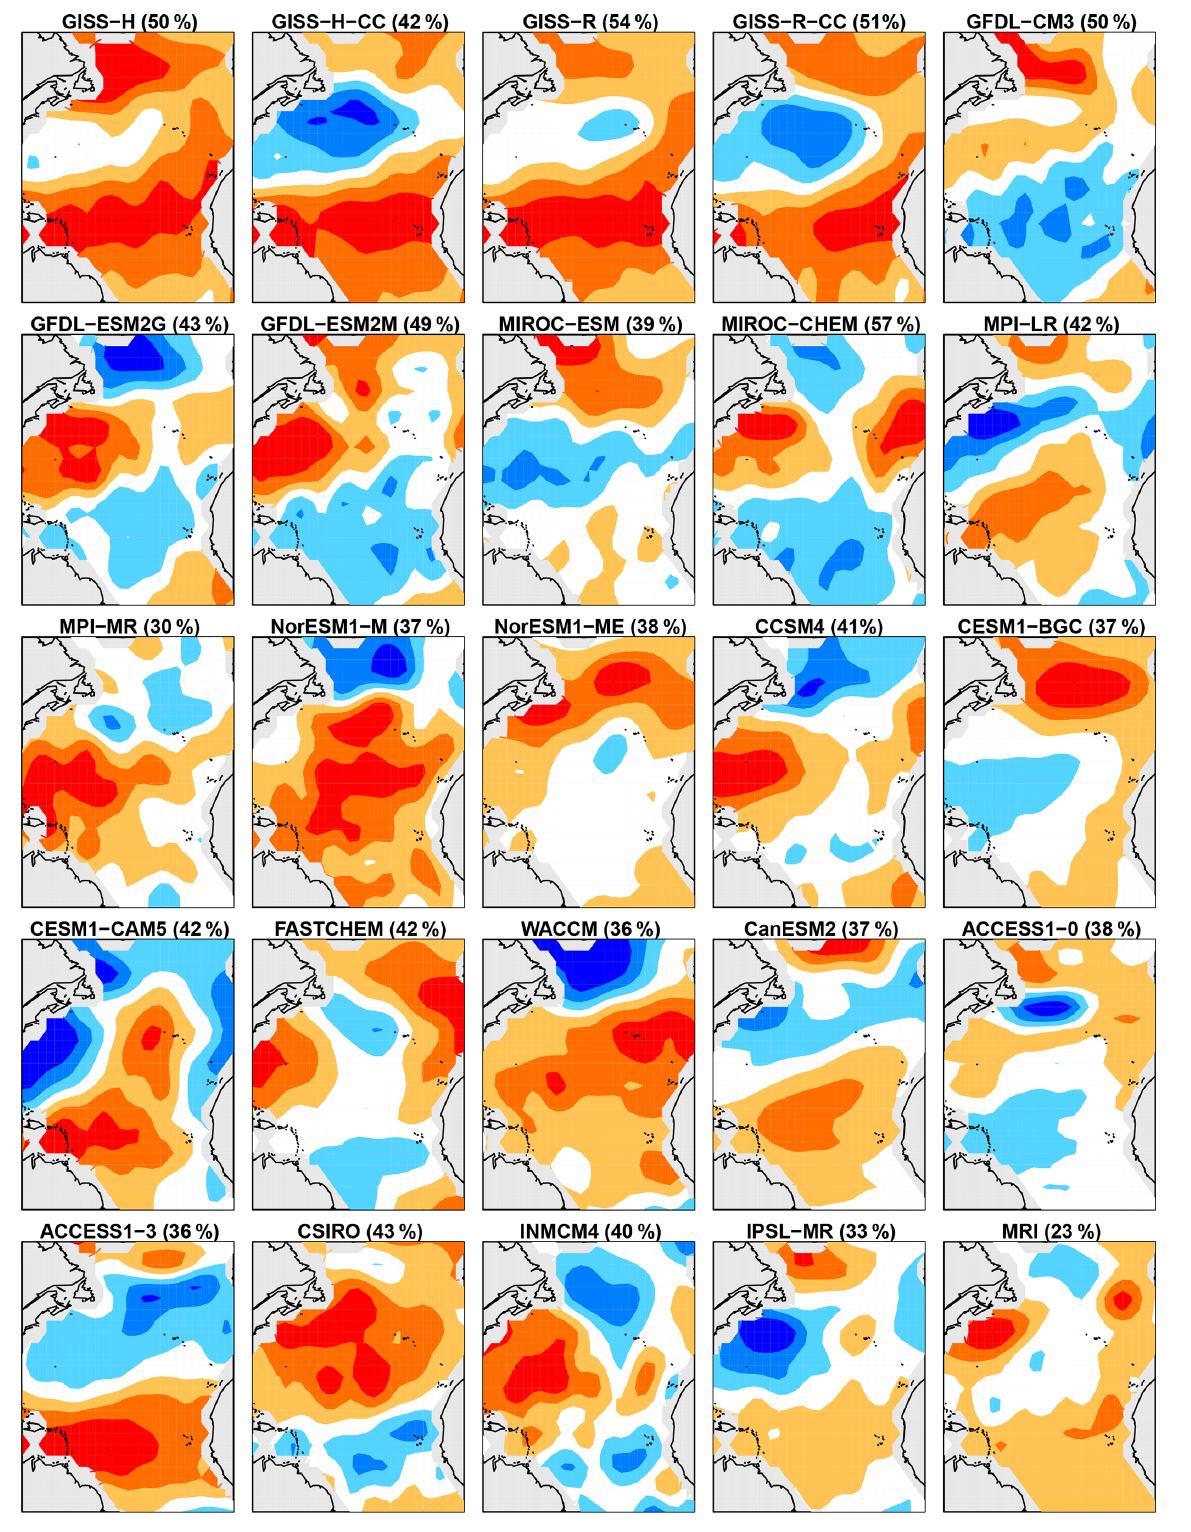
Figure 5. Same as Fig. 4 except for discriminants associated with the smallest model-to-observation variance ratio (i.e., CMIP5 models whose stochastic noises are smaller than those in